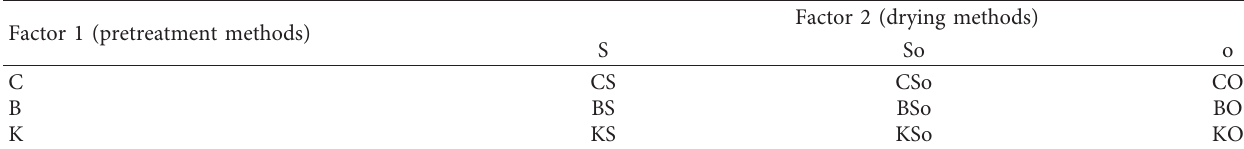
Table 1: Experimental